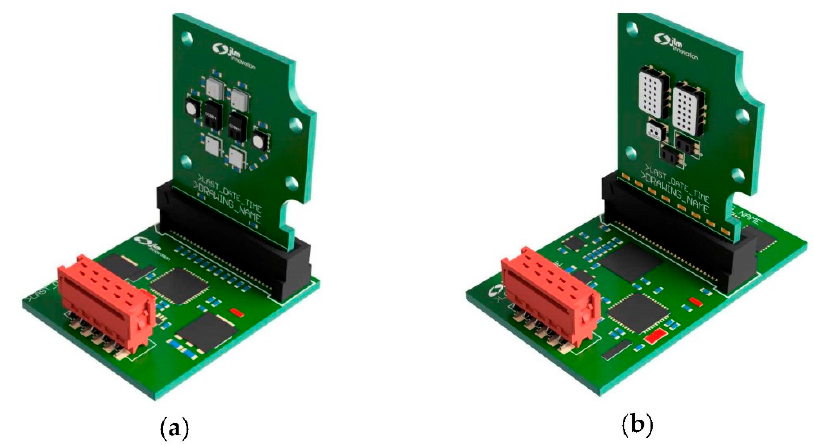
Figure 2. ( a ) Digital sensors mounted on the digital sensor board (upper) connected to the digital control board (lower) ( b ) Analog sensors mounted on the analog sensor board (upper) connected to the analog control board